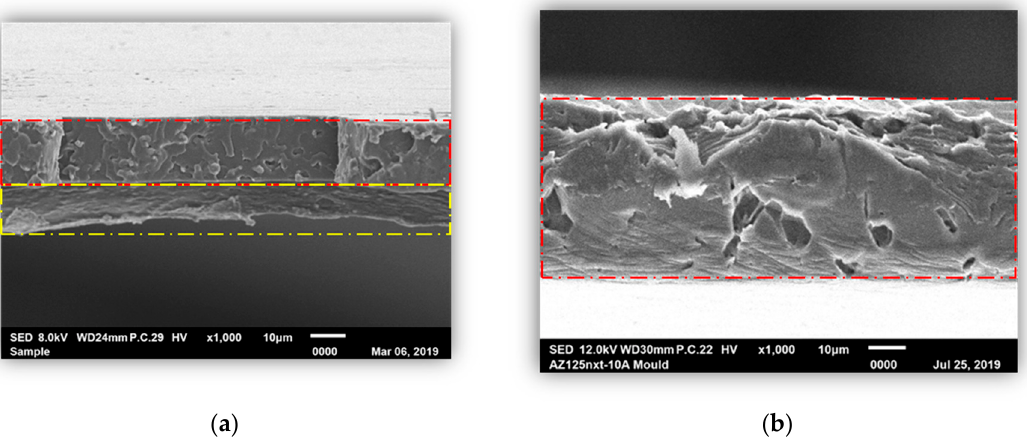
Figure 9. SEM micrographs of polylactic acid (PLA)/phycocyanin–alginate composite ( a ) before and ( b ) after the releasing test.